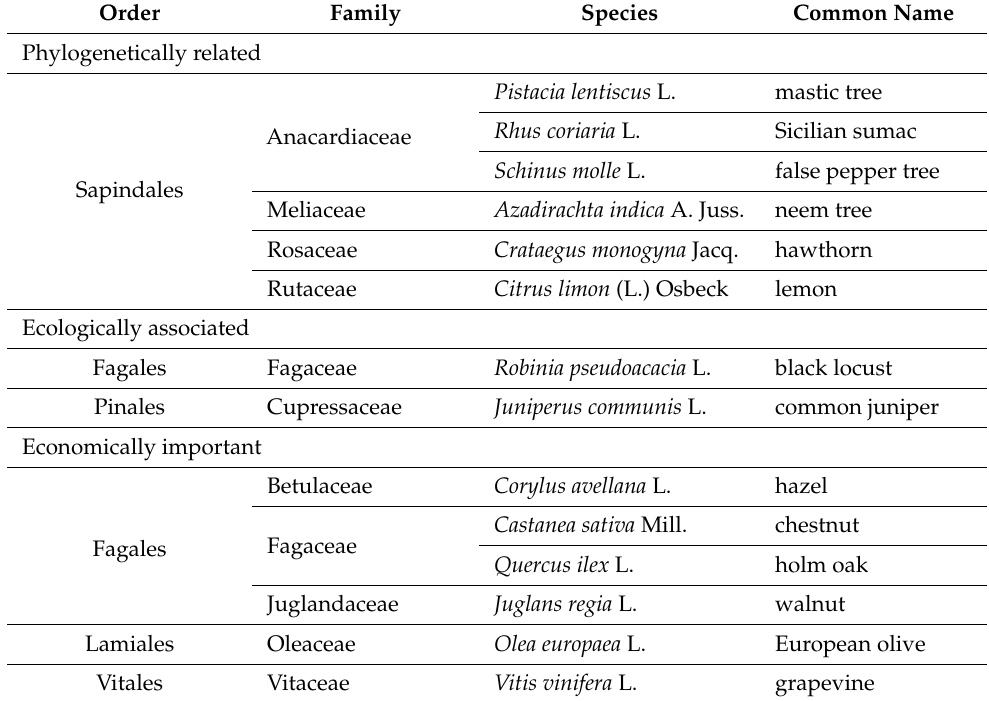
Table 1. Nontarget species selected to be tested under open-field conditions. Plant species are listed according to their phylogenetic or ecological association to tree of heaven, Ailanthus altissima , and their economic